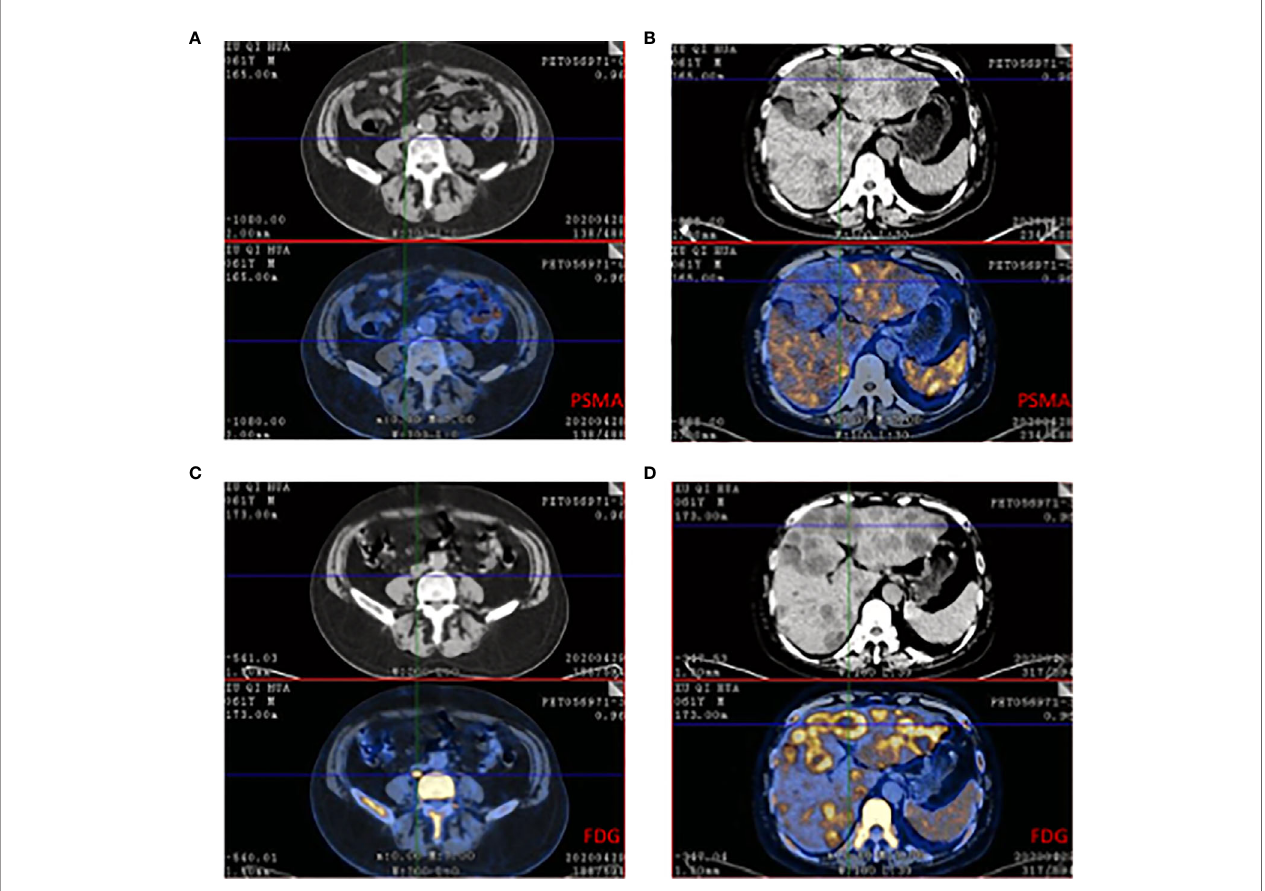
FIGURE 2 | 68 Ga-PSMA and 18F-FDG PET/CT of a 61-year-old patient who was resistant to ADT and had widespread metastases in lymph node and liver. (A) CT showed the enlarged lymph node while PSMA expression was low. (B) Multiple low-intensity lesions were in the whole liver and the largest one was in the left hepatic lobe. The PSMA PET/CT showed low absorption in the suspicious lesion. (C) The same plane compared to A, FDG showed high absorption beside the vertebra. The size was 25*18mm and Sova=14.1. (D) The same plane compared to B, FDG showed heterogeneous enhanced in liver and